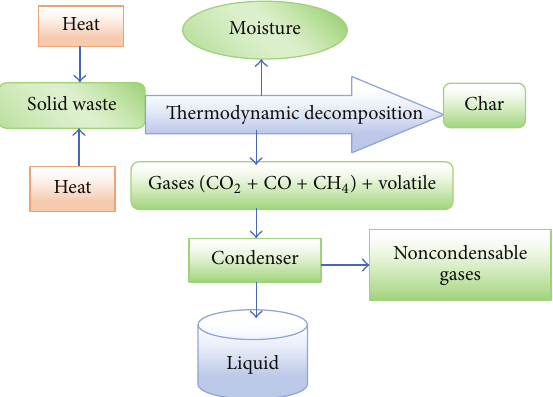
Figure 1: Steps of pyrolysis